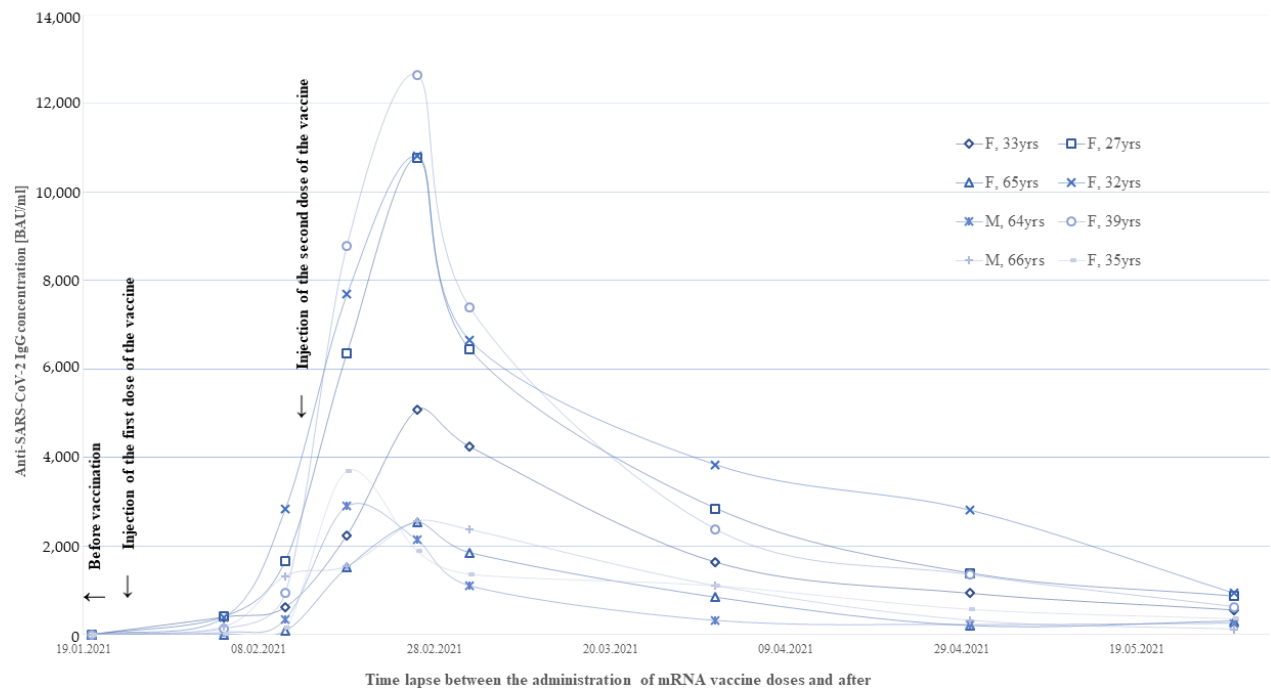
Figure 3. IgG-anti-SARS-Cov-2 concentrations in the first 4 months after receiving the mRNA vaccine for 8 seronegative individuals.